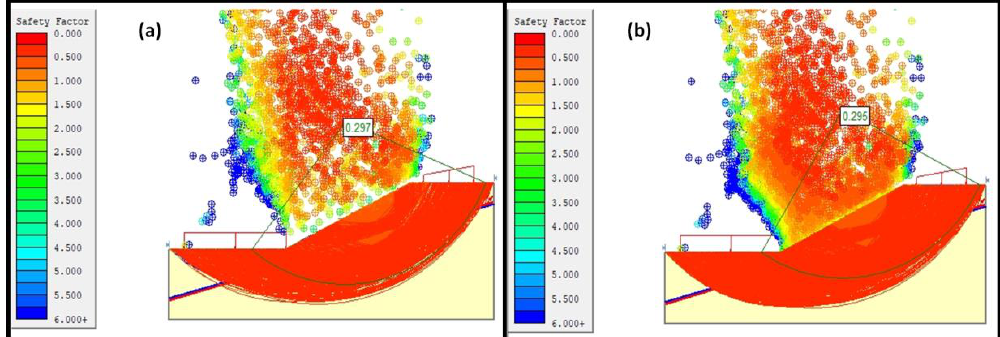
Figure 22. Safety factor simulated for rainy conditions in silt clay soil slope using ( a ) Lower Karafiath method and ( b ) Gle/Morgenstern Price method.